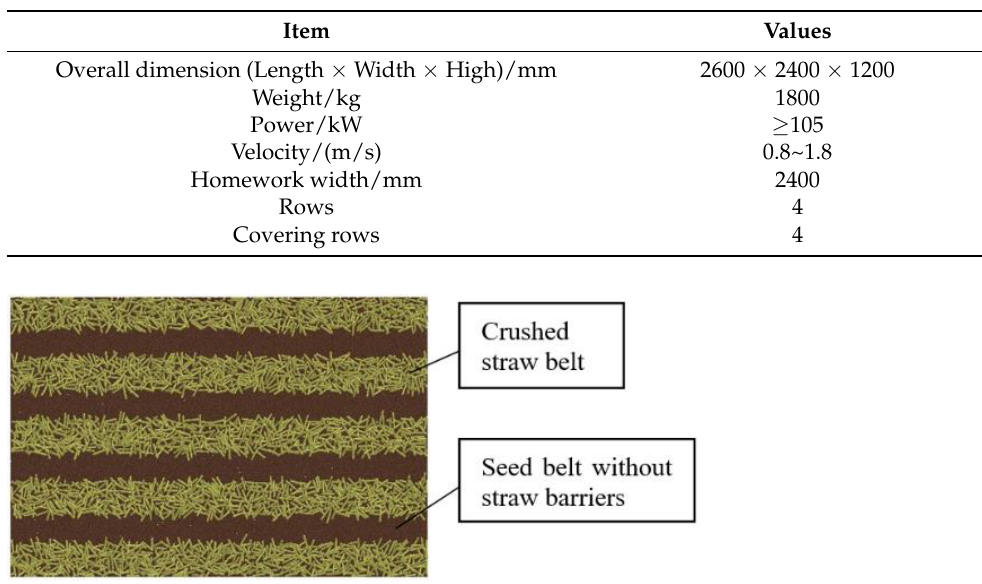
Figure 3. Structure of the wide-boundary planter with crushed straw inter-row mulching. Table 1. Main technical parameters.